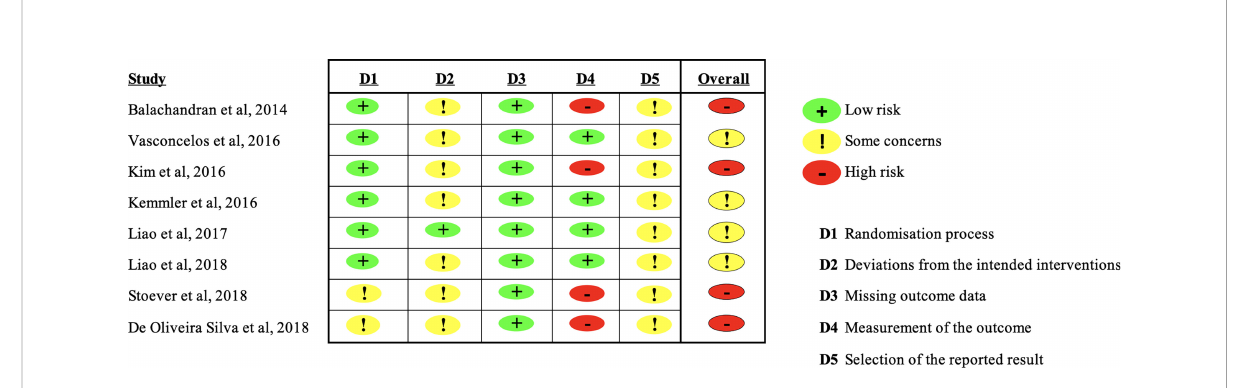
FIGURE 1 Summary of Risk of bias in the included